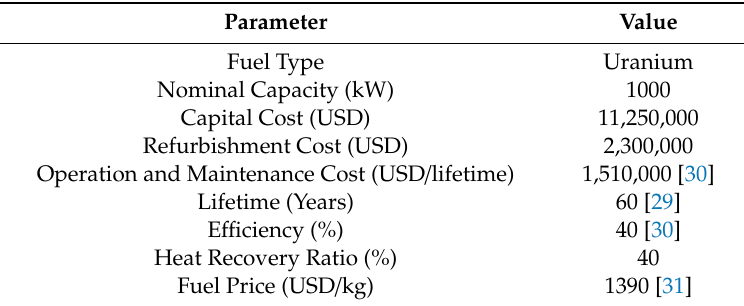
Table 4. Specifications of the MMR.